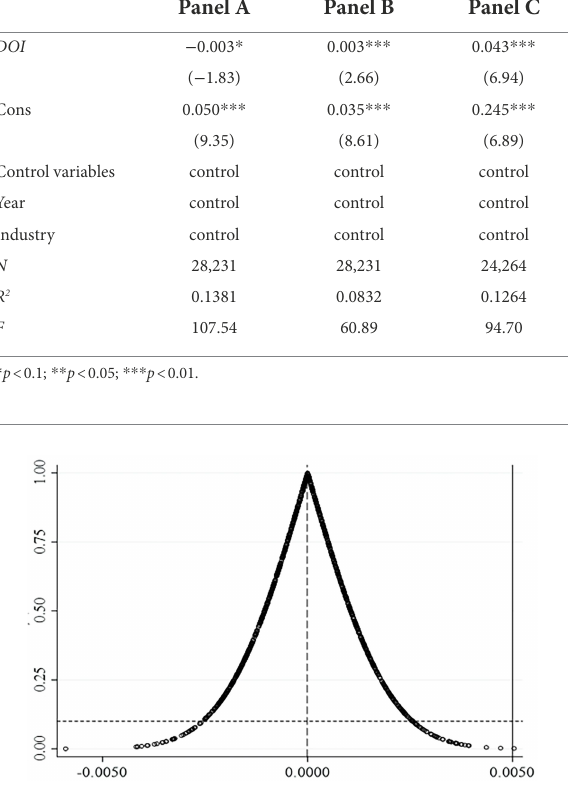
FIGURE 1 The result of placebo test. The horizontal axis represents the coefficient and the vertical axis represents the value of p .